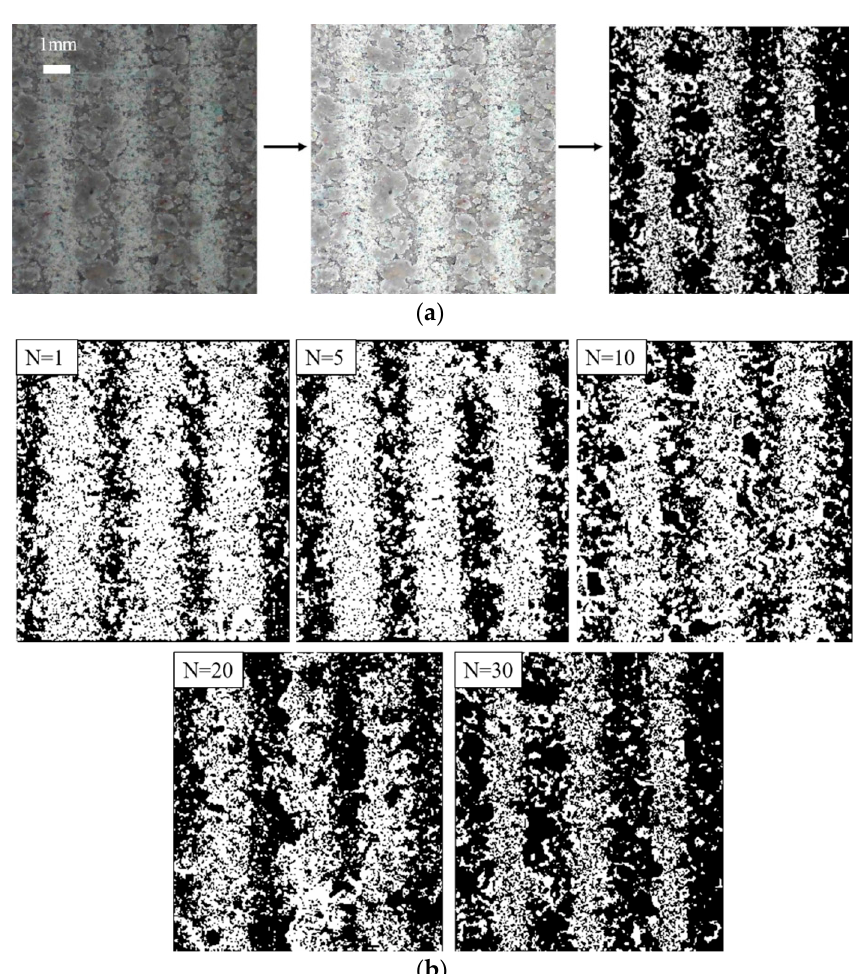
Figure 18. Surface image enhancement for frozen cement-treated sand specimens after testing at the different number of cycles. ( a ) Example of surface image enhancement for a frozen cement-treated sand specimen after testing; ( b ) Surface image enhancement for different number of cycles with T = − 10 °C, σ N = 300 kPa.